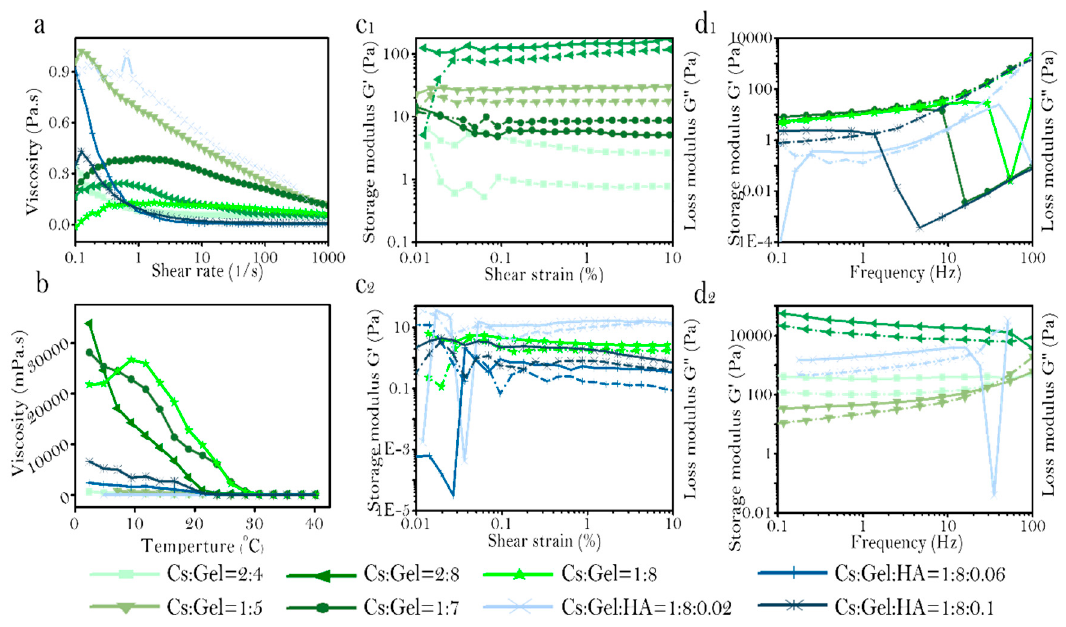
Figure 2. Rheological properties of bio-ink. ( a ): Shear rate, ( b ): Viscosity profile, ( c 1 , c 2 ): Strain, and ( d 1 , d 2 ): Frequency.